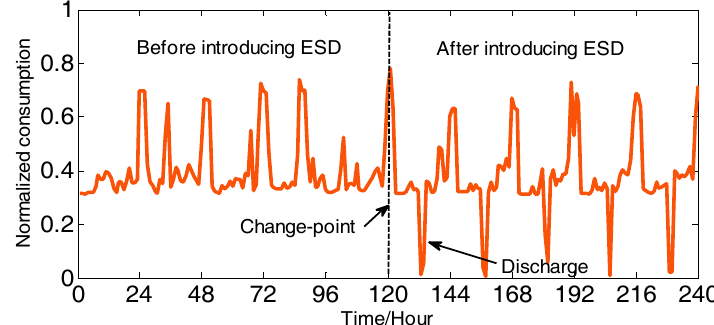
Figure 12. The simulated net load profiles of a customer without DPVSs before and after introducing a household ESD.